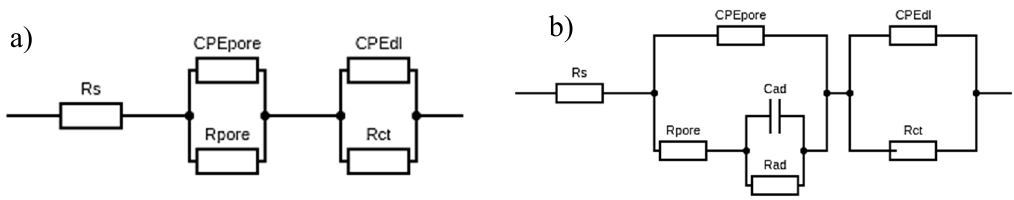
Figure 12. Sand-blasted sample with the DLC coating: ( a ) Nyquist diagram and ( b ) Bode diagram. ◦ : log(Z); +: -phase/deg.